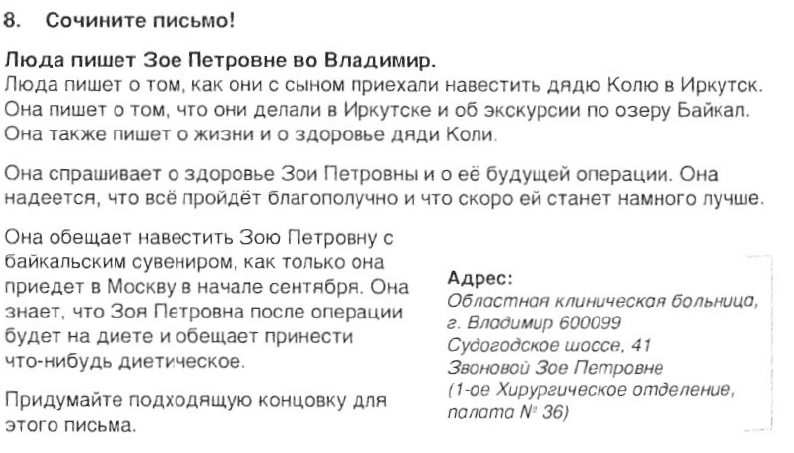
Figure 5. Example 1 of a task in Molodets .